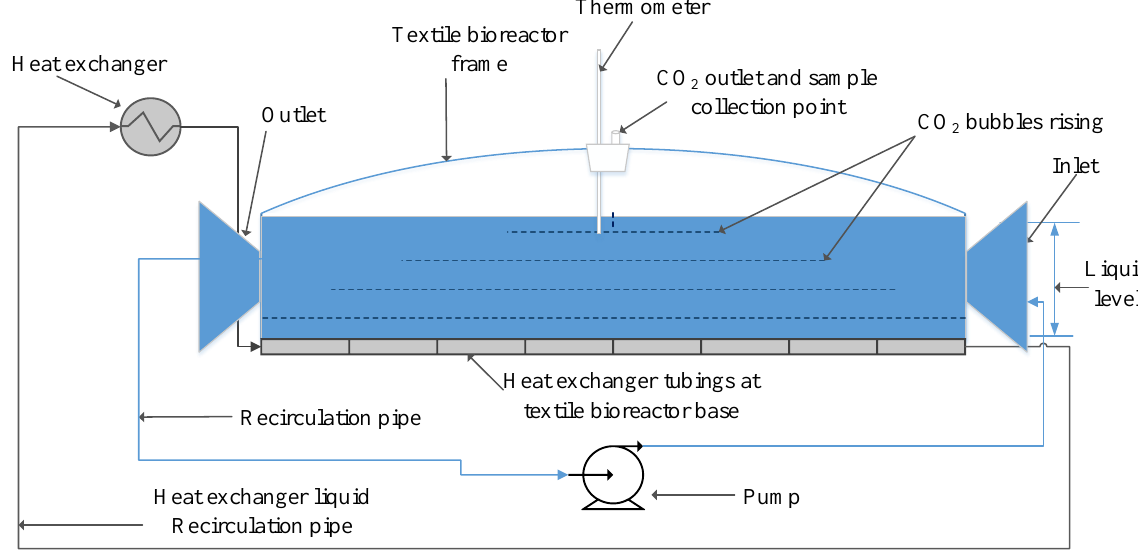
Figure 5. Schematic diagram of the textile bioreactor lab scale prototype